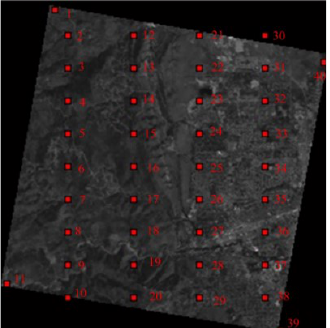
Figure 14. The distribution of the forty CPs labelled as read in the georeferenced image. Table 1. The comparison of gray value of Cps.